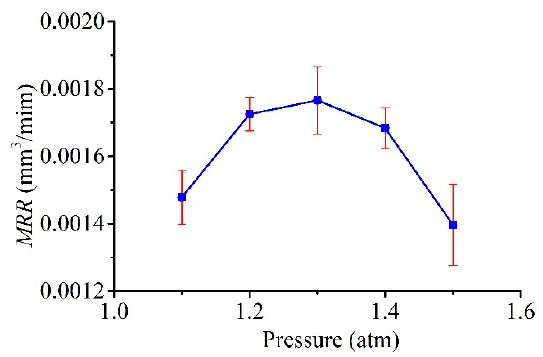
Figure 14. E ff ect of pressure P 1 on the material removal rate (MRR). Figure 14. Effect of pressure P 1 on the material removal rate (MRR).